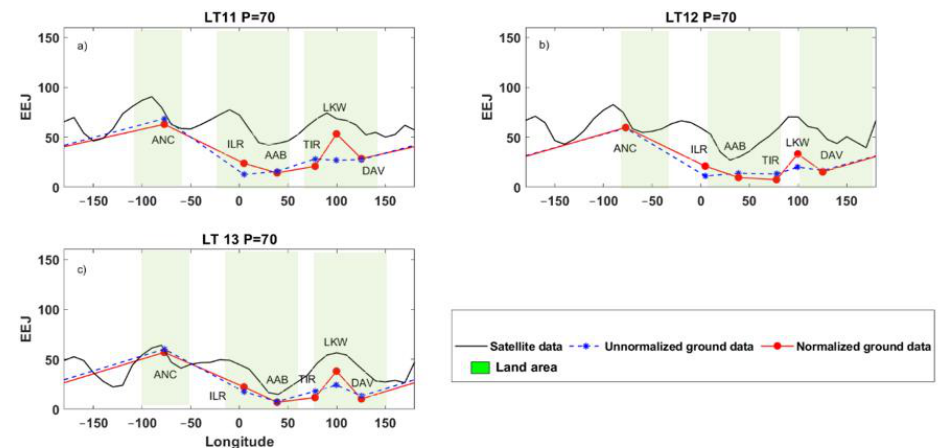
Figure 2. The longitudinal variation of the EEJ current derived from ground (nT) and satellite (mA/m) data during low solar activity level ( P = 70) at ( a ) 11 LT ( b ) 12 LT and ( c ) 13 LT.